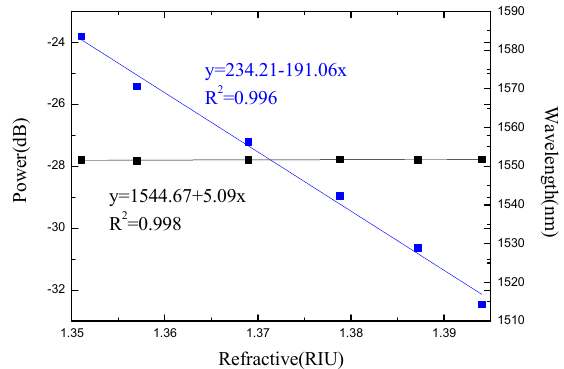
Figure 9. The refractive index response of the Michelson interferometer.